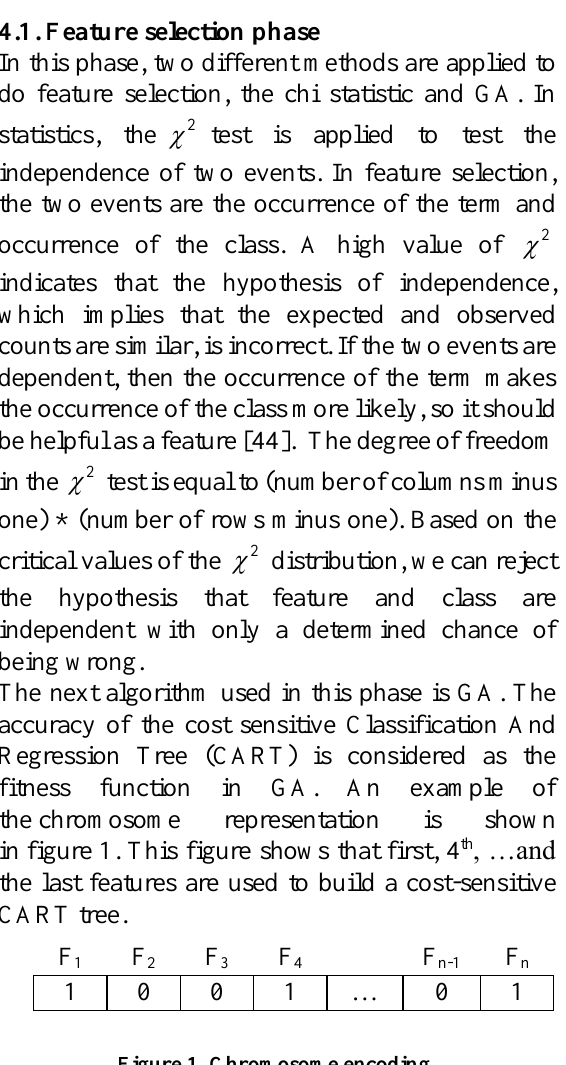
Figure 1. Chromosome